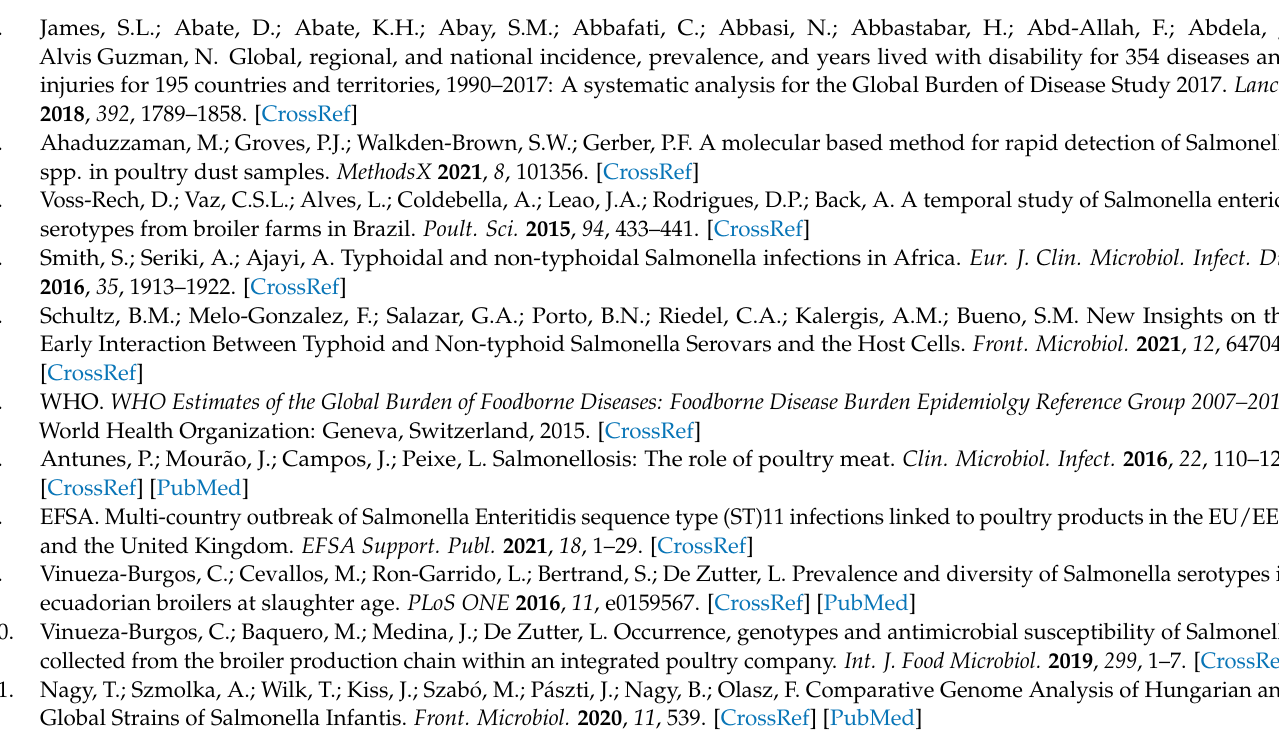
tion; Table S2: COBB 500 Feed components and proximate composition of starter (0–8 days) diets; Figure S1: DNA integrity; Supplementary